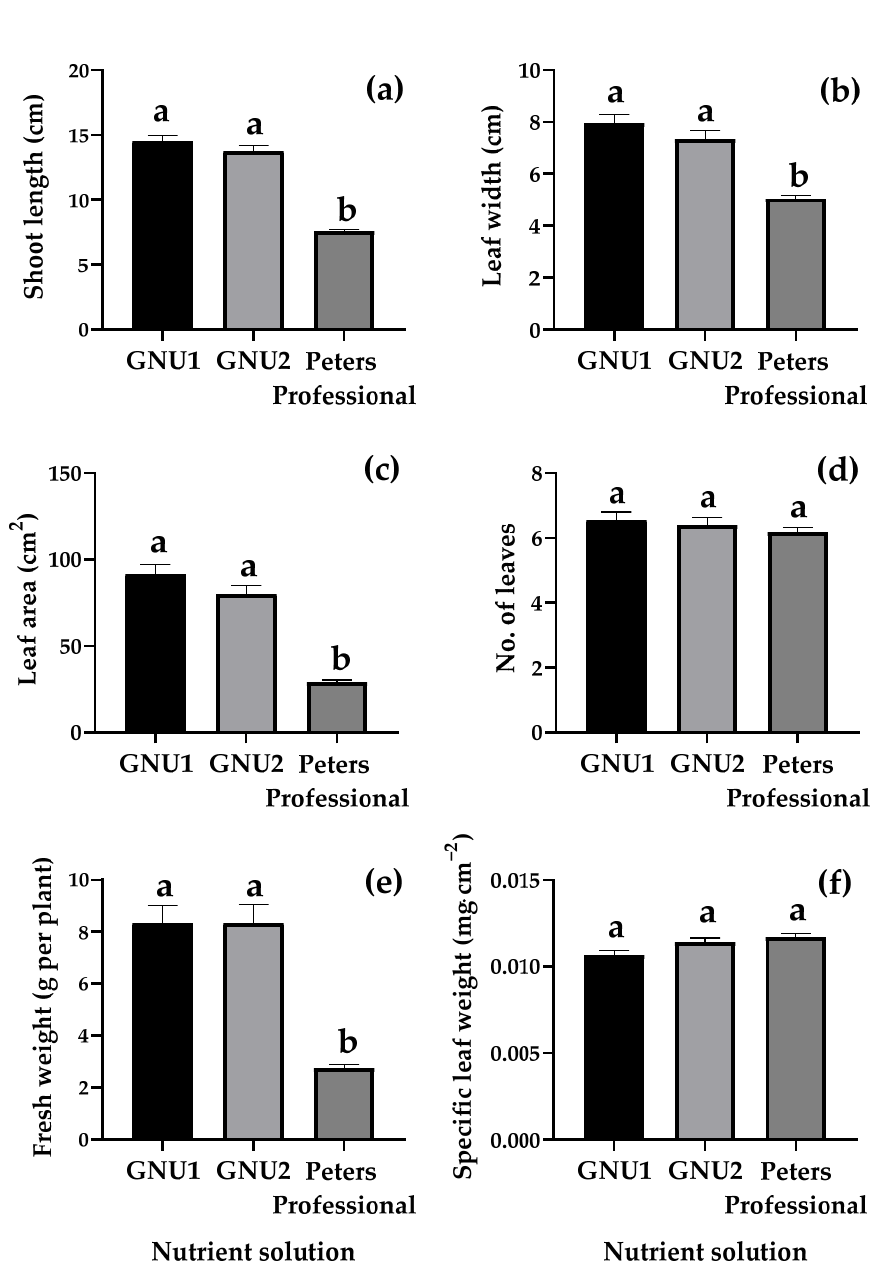
Figure 2. Growth of Ssamchoo as affected by nutrients 28 days after sowing in Experiment 1. Peters Professional, GNU1, and GNU2 were the nutrient solutions used in the experiment. Peters Profes- sional is a commercial nutrient solution.